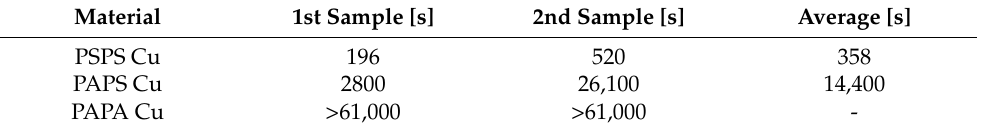
Table 2. Detachment time of three di ff erent material combinations of joint substrates with adsorbed copper(II). PS–PS represents two PS substrates, PA 12–PS is a combination of one PS and one PA